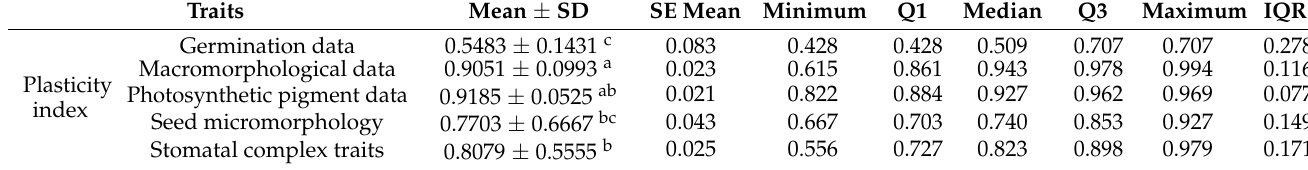
Table 4. Descriptive plasticity index (PI) values for all of the studied data of Trianthema portulacastrum , showing significant comparisons between them. Groups that share same letters are non-significant while different letters represent significantly different groups.